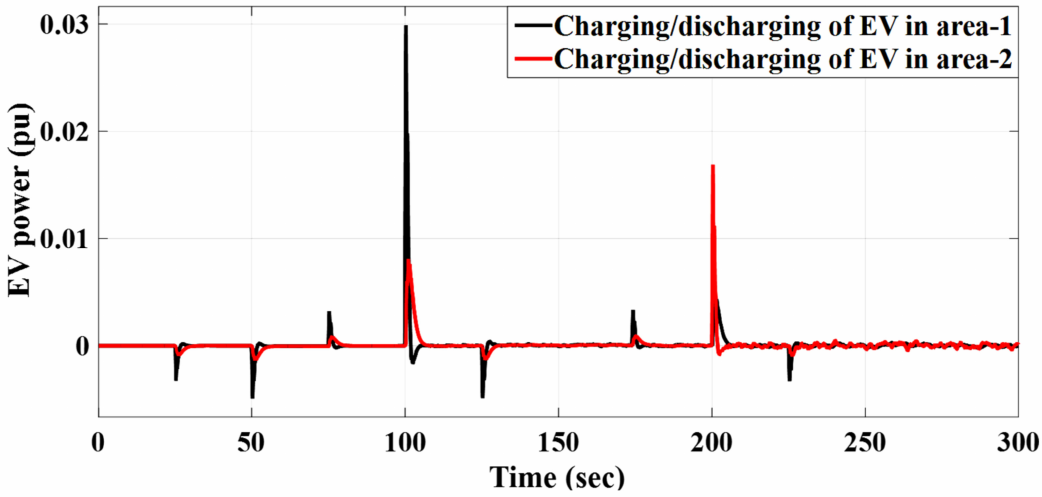
Figure 28. The charging/discharging power of the applicable EVs in both